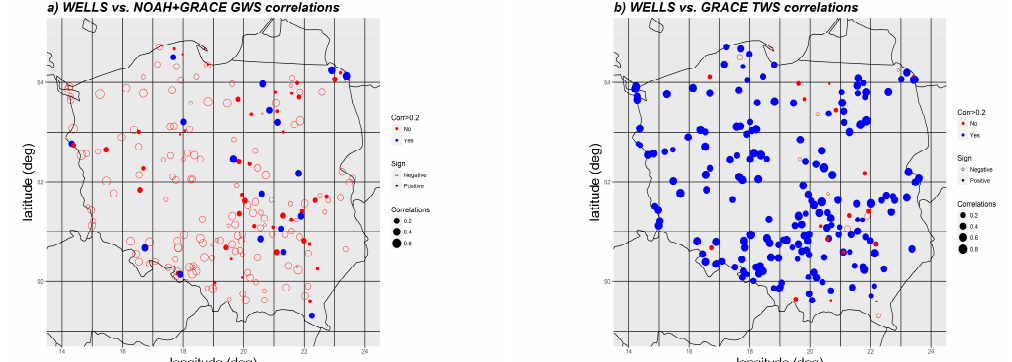
Figure 6. Correlations between the thickness of the unsaturated zone at the location of the well and GWS ( a ) and the thickness of the unsaturated zone at the location of the well and GRACE ( b ).